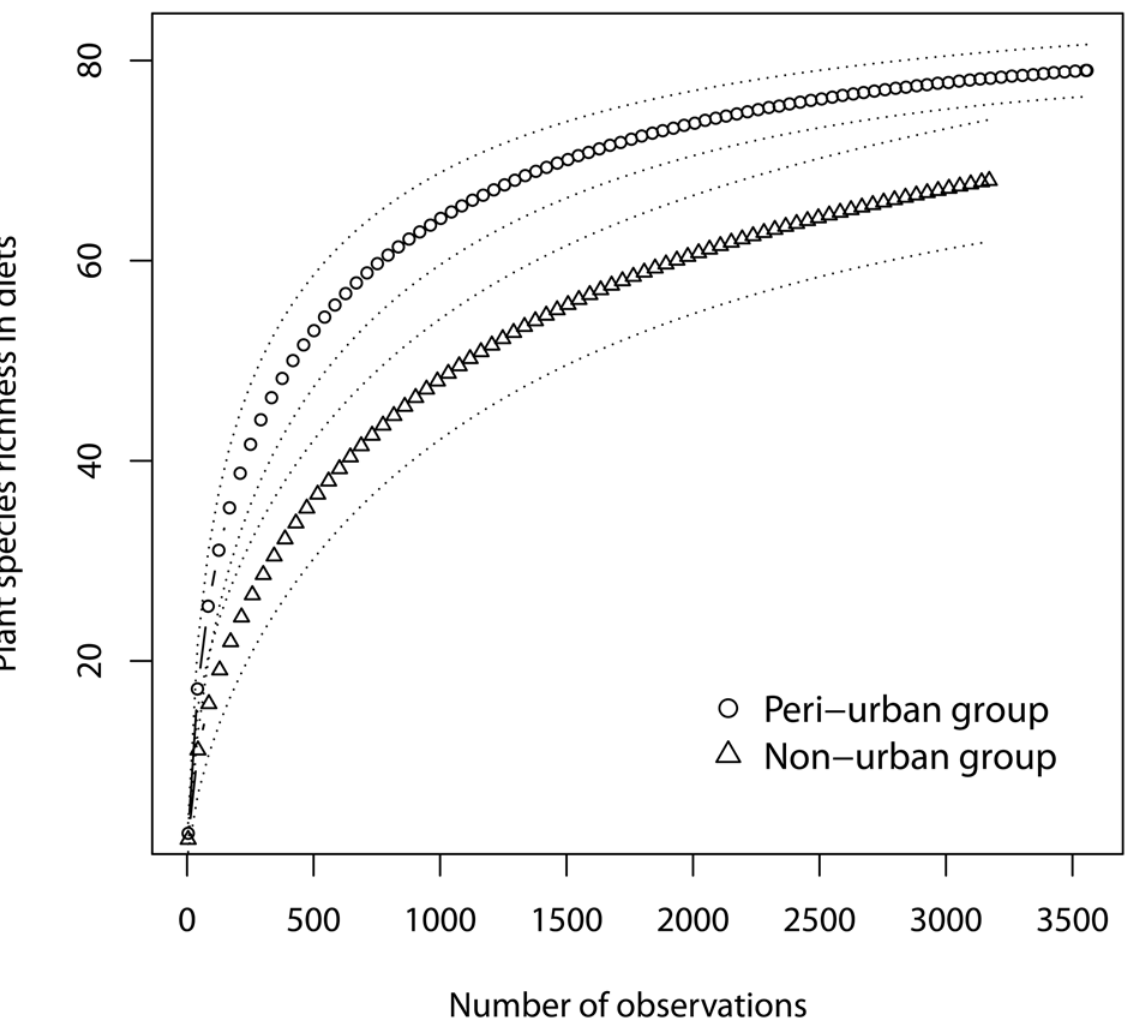
Fig 3. Plant species richness of the macaques ’ diets in the two sites. Rarefaction curves represent the cumulative numbers of observed eaten species. Randomized species richness is represented as a function of the number of eaten food items we sampled. Symbols are plotted every 10 hours of observation. Dashed lines indicate 95% confidence